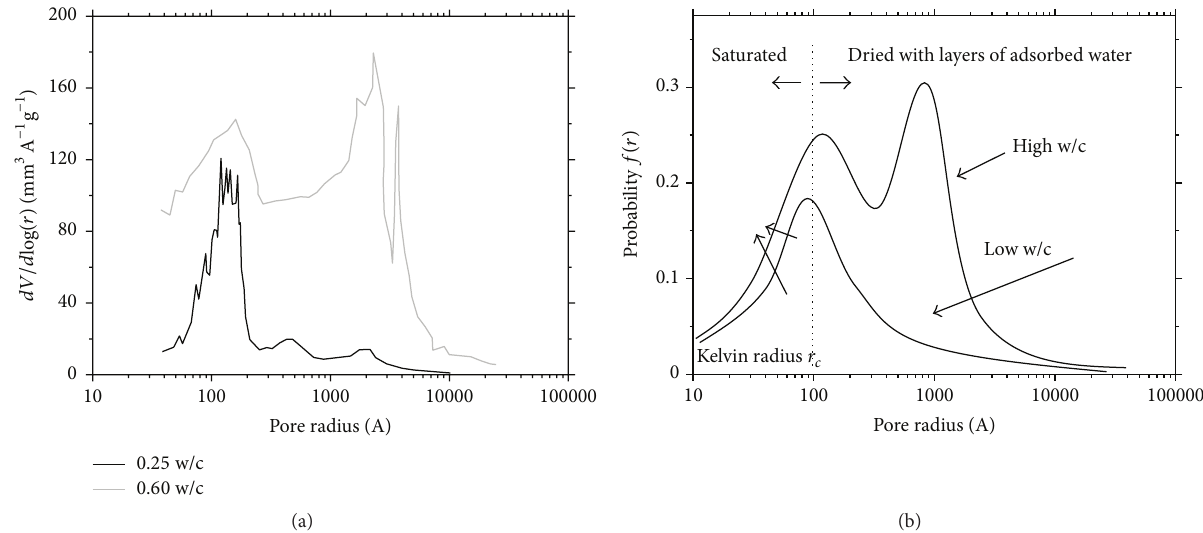
Figure 3: (a) Pore size distribution for OPC with w/c = 0.6 and w/c = 0.25 (data adopted from Figure 10(a) in [15], where the averaged data points are selected to represent the approximate pore size distribution profiles). (b) Comparison of pore size distribution of typical high w/c OPC and low w/c OPC and their corresponding capillary water